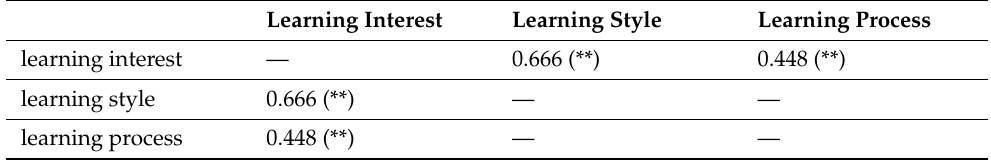
Table 3. Correlation Analysis.